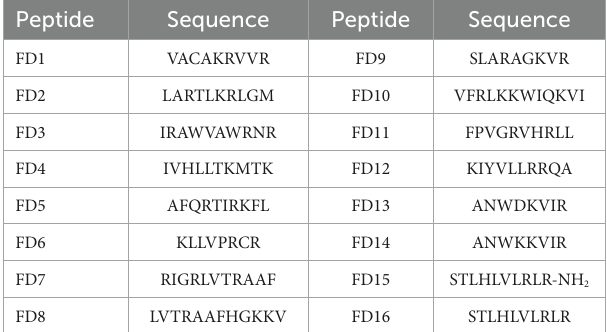
TABLE 1 Amino acid sequences of candidate peptides.